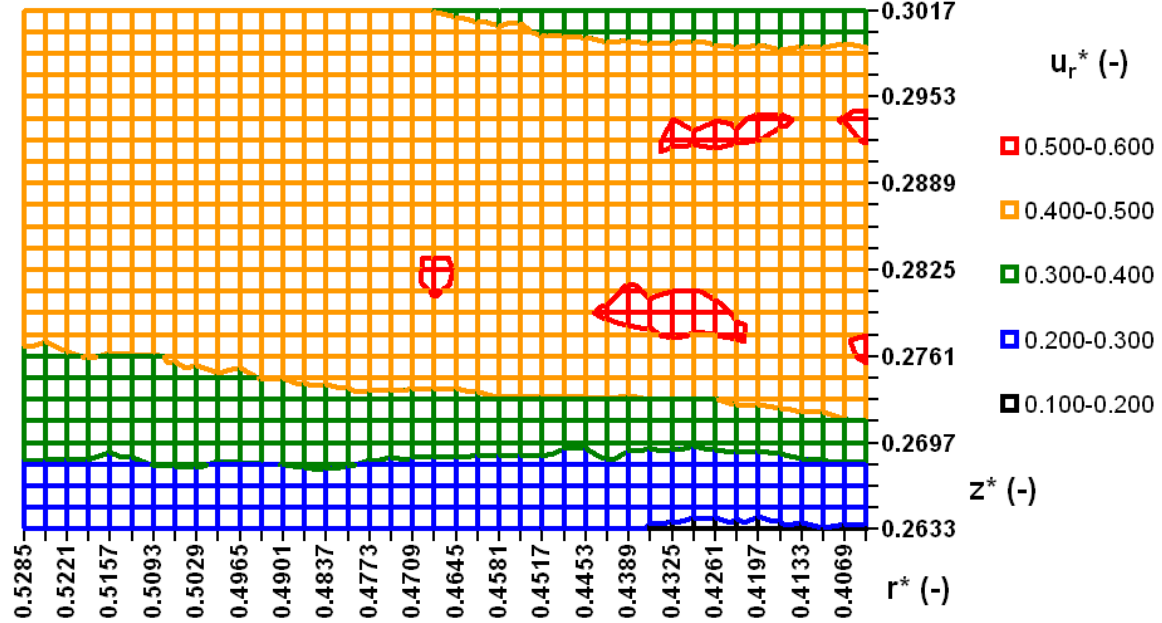
Fig. 4. Dimensionless radial fluctuation velocity distribution u r* = )/( NDu